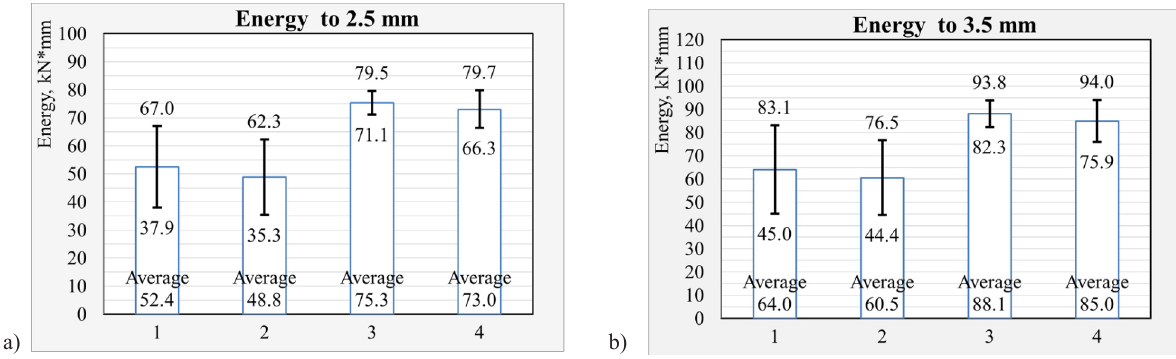
(b)a) Fig. 9. Energy spent reaching deflection equal to 2.5 mm (a), and 3.5 mm